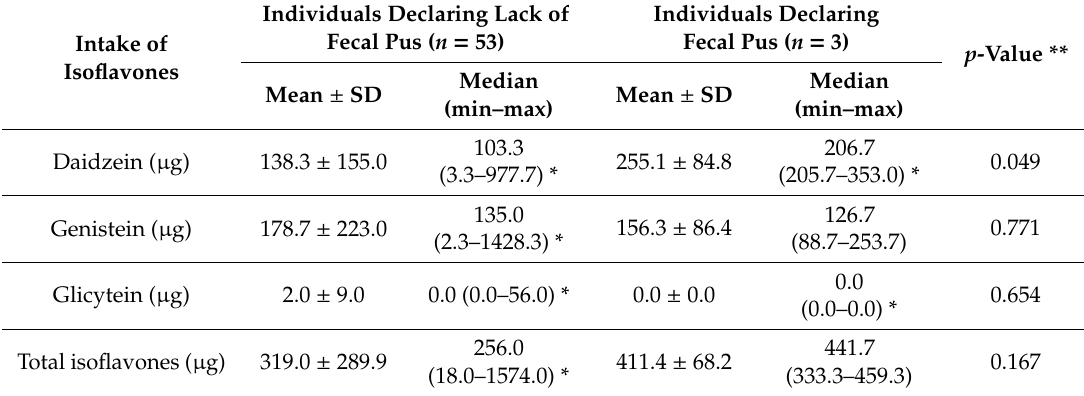
Table 6. The isoflavone intakes in groups of individuals with ulcerative colitis declaring either lack or presence of fecal pus.